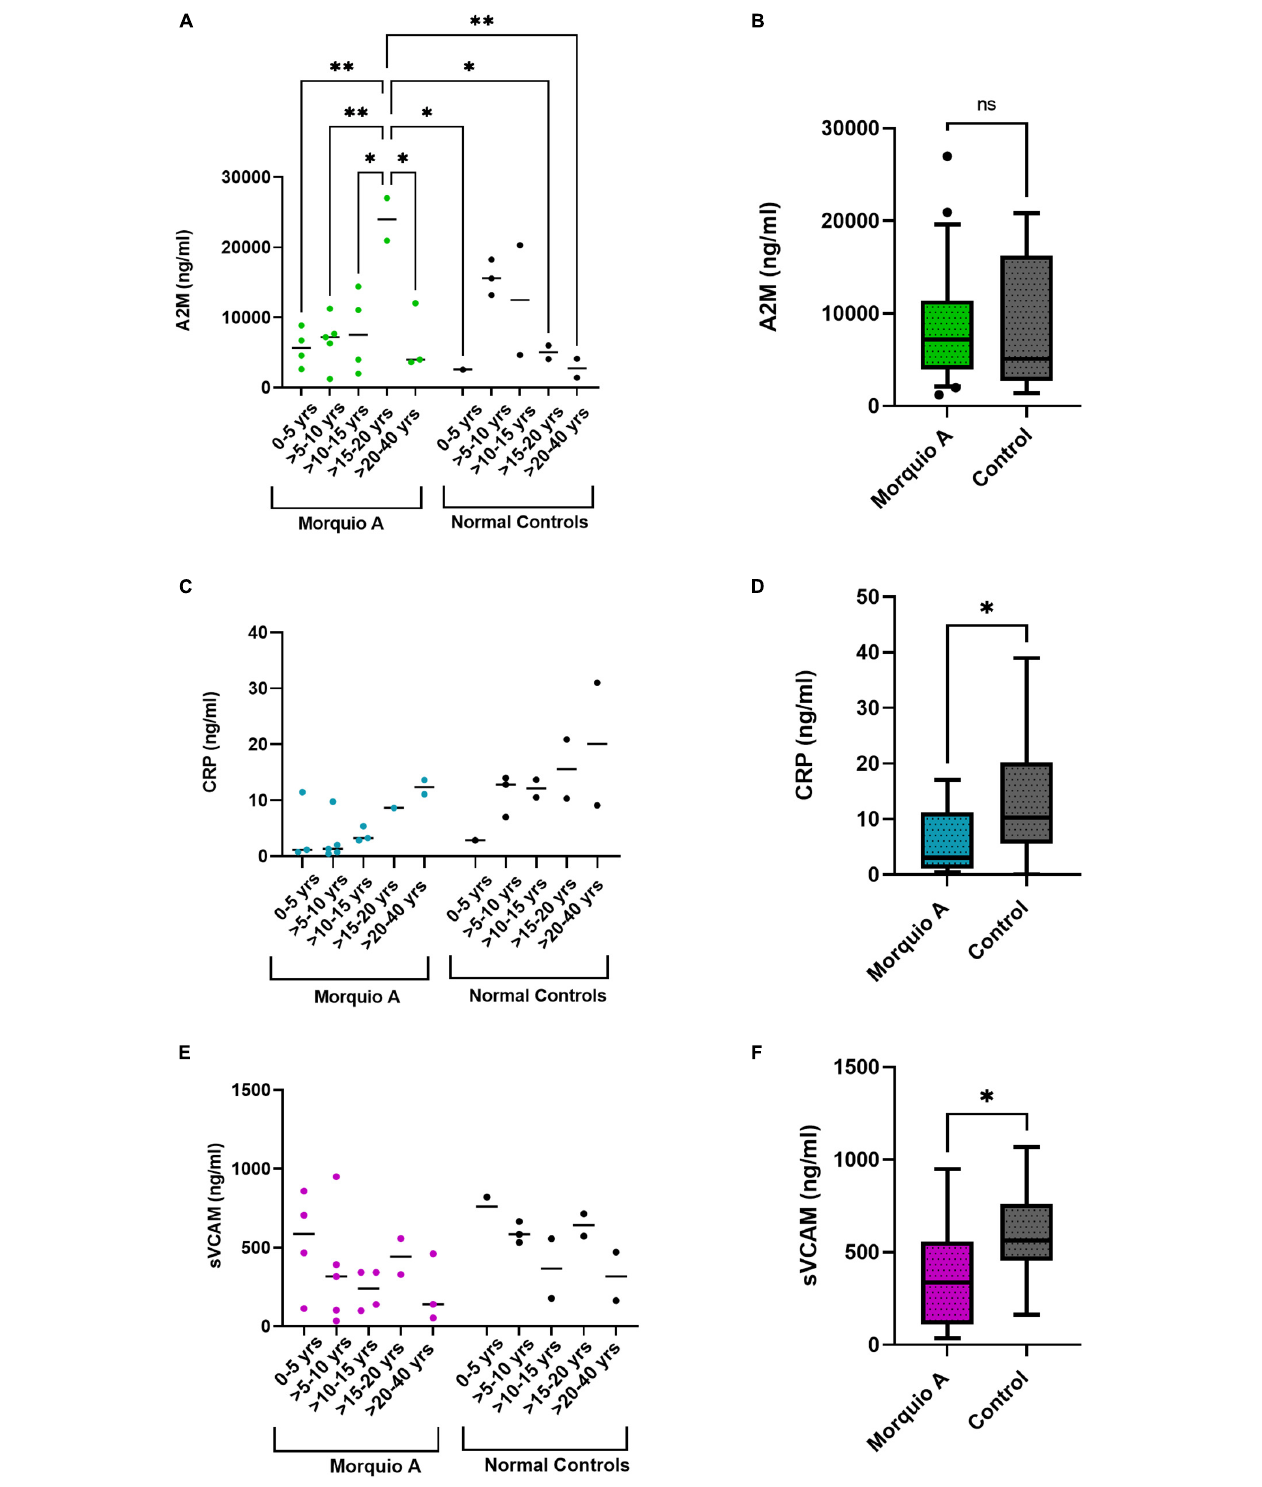
FIGURE 6 | Comparison of cardiovascular biomarkers between Morquio A and normal controls. Scatter plot and comparison of (A,B) α -2-macroglobulin [A2M], (C,D) C-reactive protein [CRP], and (E,F) circulating vascular cell adhesion molecule-1 [sVCAM-1], between Morquio A and normal controls stratified (A,C,E) or non-stratified (B,D,F) by age groups. Significant differences are denoted with asterisks ( ∗ p ≤ 0.05, ∗∗ p ≤ 0.01). p -values were determined by one-way ANOVA followed by ordinary one-way ANOVA multiple comparisons test.